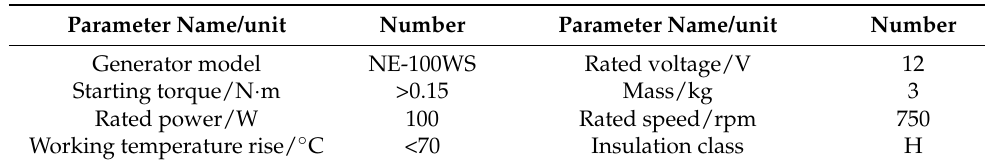
Table 3. Specific parameters of small generator.